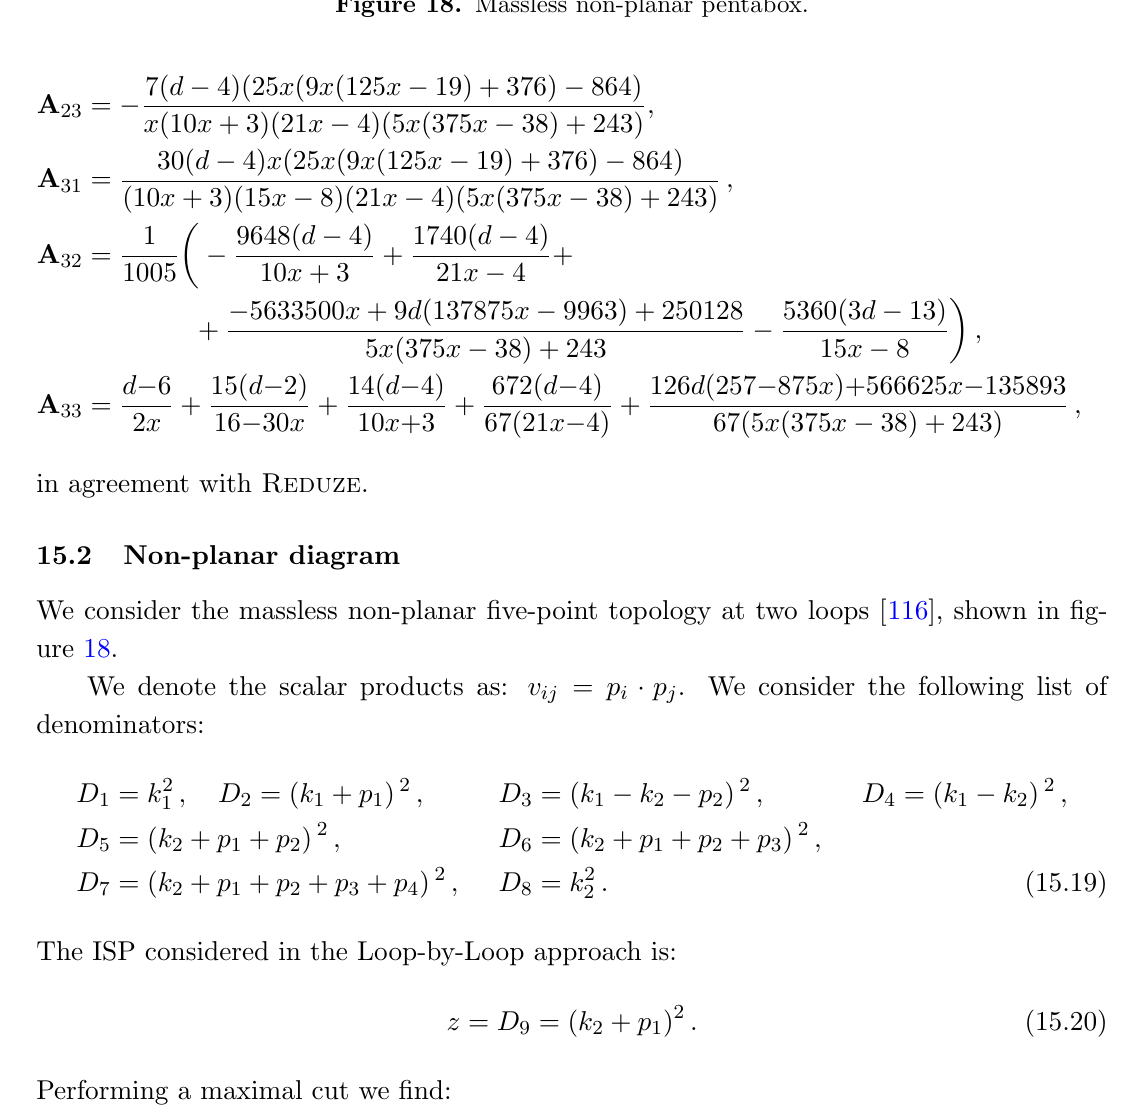
Figure 18. Massless non-planar